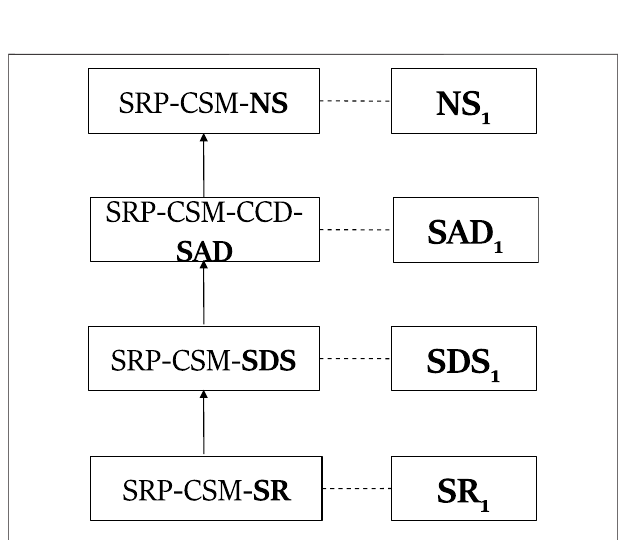
FIGURE 5 | The PL structure created and used by SBR for the ROSA problem.